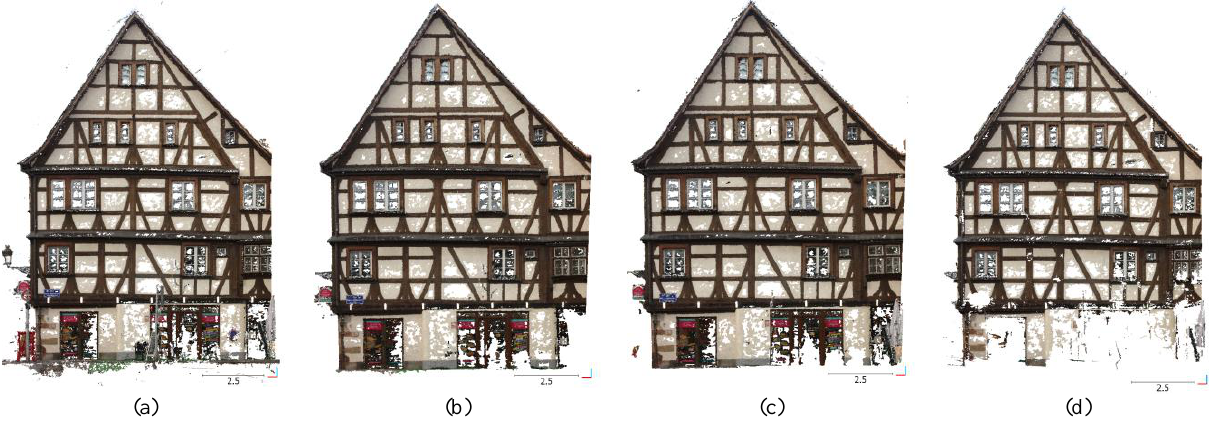
Figure 5. Dense point cloud results from (a) raw dense matching without noise cleanup, (b) manual cleaning on CloudCompare, (c) automatic noise exclusion via manual image masks and (d) automatic noise exclusion via AI-created image